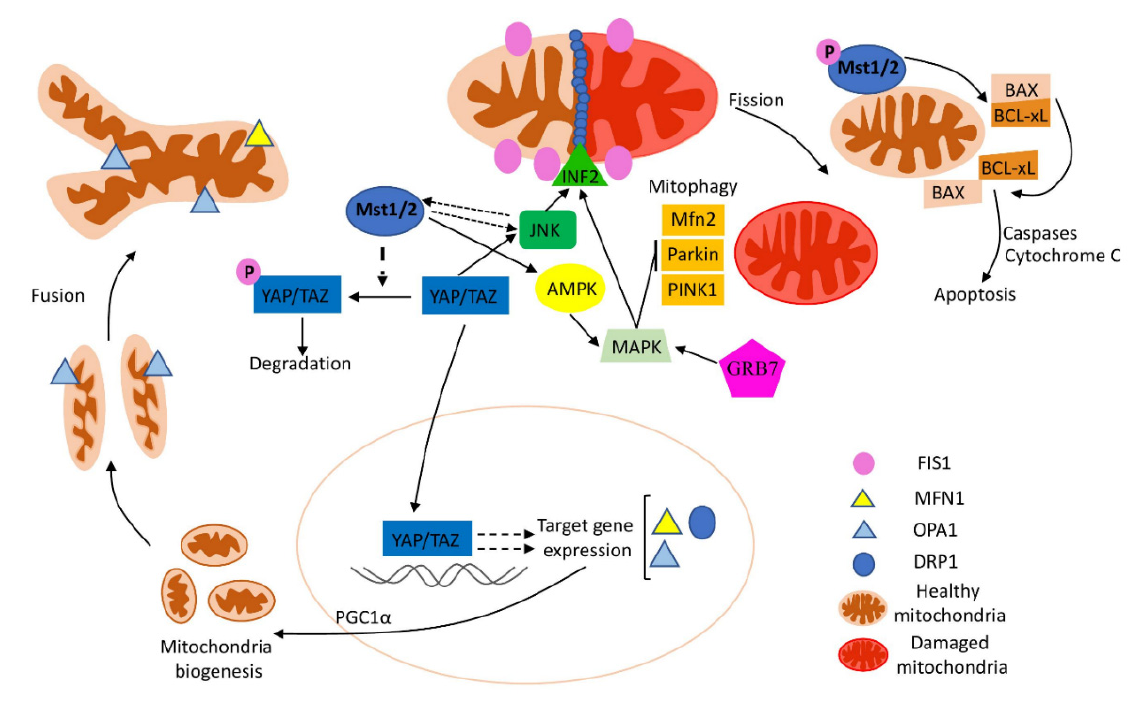
Figure 2. The role of the Hippo pathway in the regulation of mitochondrial biogenesis, mitochon- dria-mediated apoptosis, mitochondrial dynamics, and mitophagy. When the Hippo pathway is ‘‘off’’, YAP combines with TAZ to target the expression of mitochondria-related genes (to regulate mitochondrial biogenesis, dynamics, and mitophagy). In addition, the components of the Hippo pathway closely interact with the JNK/MAPK pathway to regulate mitochondrial dynamics and mitophagy. Arrows or blunt ends indicate regulation or inhibition, respectively, dashed arrow— skipped steps/components in the pathway. Drp1—dynamin-related protein 1, Mfn1/2—mi- tofusin1/2, OPA1—optic atrophy protein 1, INF2—inverted formin 2, JNK—c-Jun N-terminal ki- nase, MAPK—mitogen-activated protein kinase, PGC1 α —peroxisome proliferator-activated recep- tor-a coactivator 1, PINK1—PTEN-Induced Kinase 1, YAP—Yes-Associated Protein 1, TAZ—Ta- fazzin, BAX—BCL2-Associated X, BCL-xL—Apoptosis Regulator Bcl-X, GRB7—Growth Factor Re- ceptor Bound Protein 7.